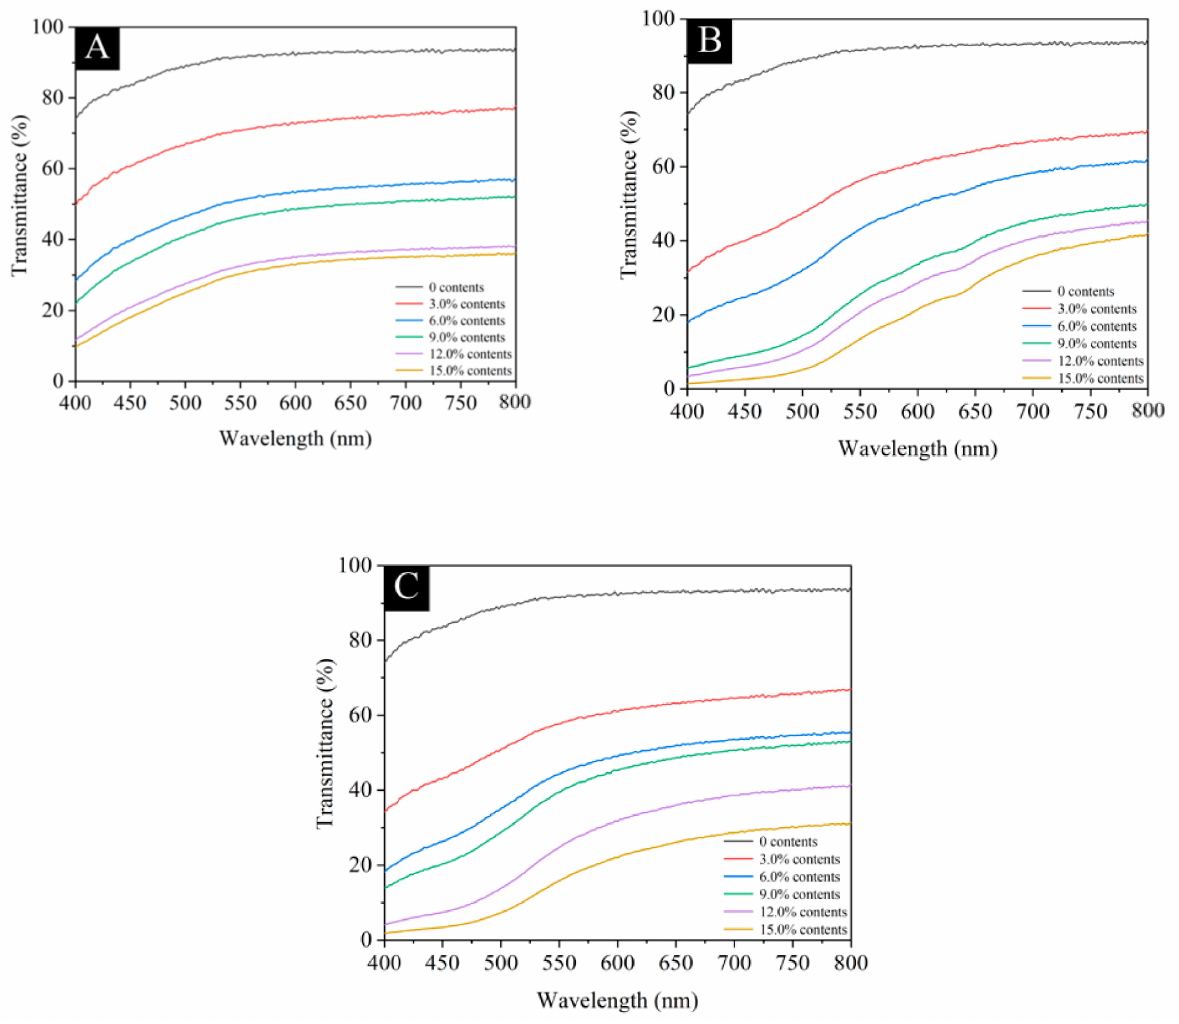
Figure 7. UV transmittance curves of microcapsule coatings with different shellac: ( A ) transparent shellac microcapsules, ( B ) purple shellac microcapsules, ( C ) yellow shellac